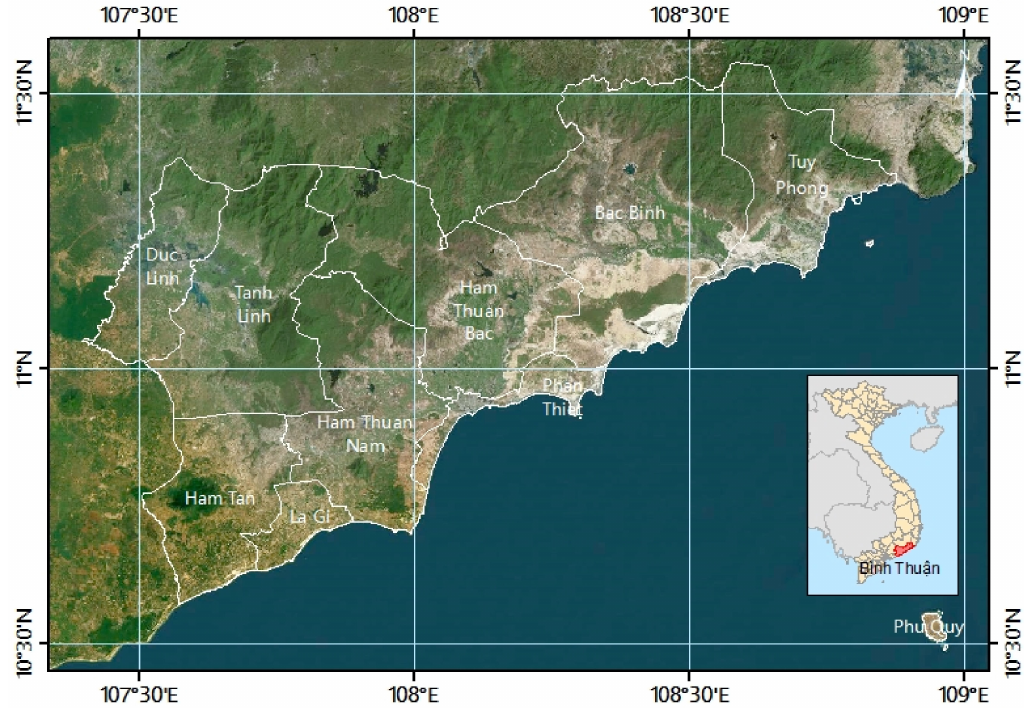
Figure 1. Map of location and administrative divisions of the Binh Thuan Province.